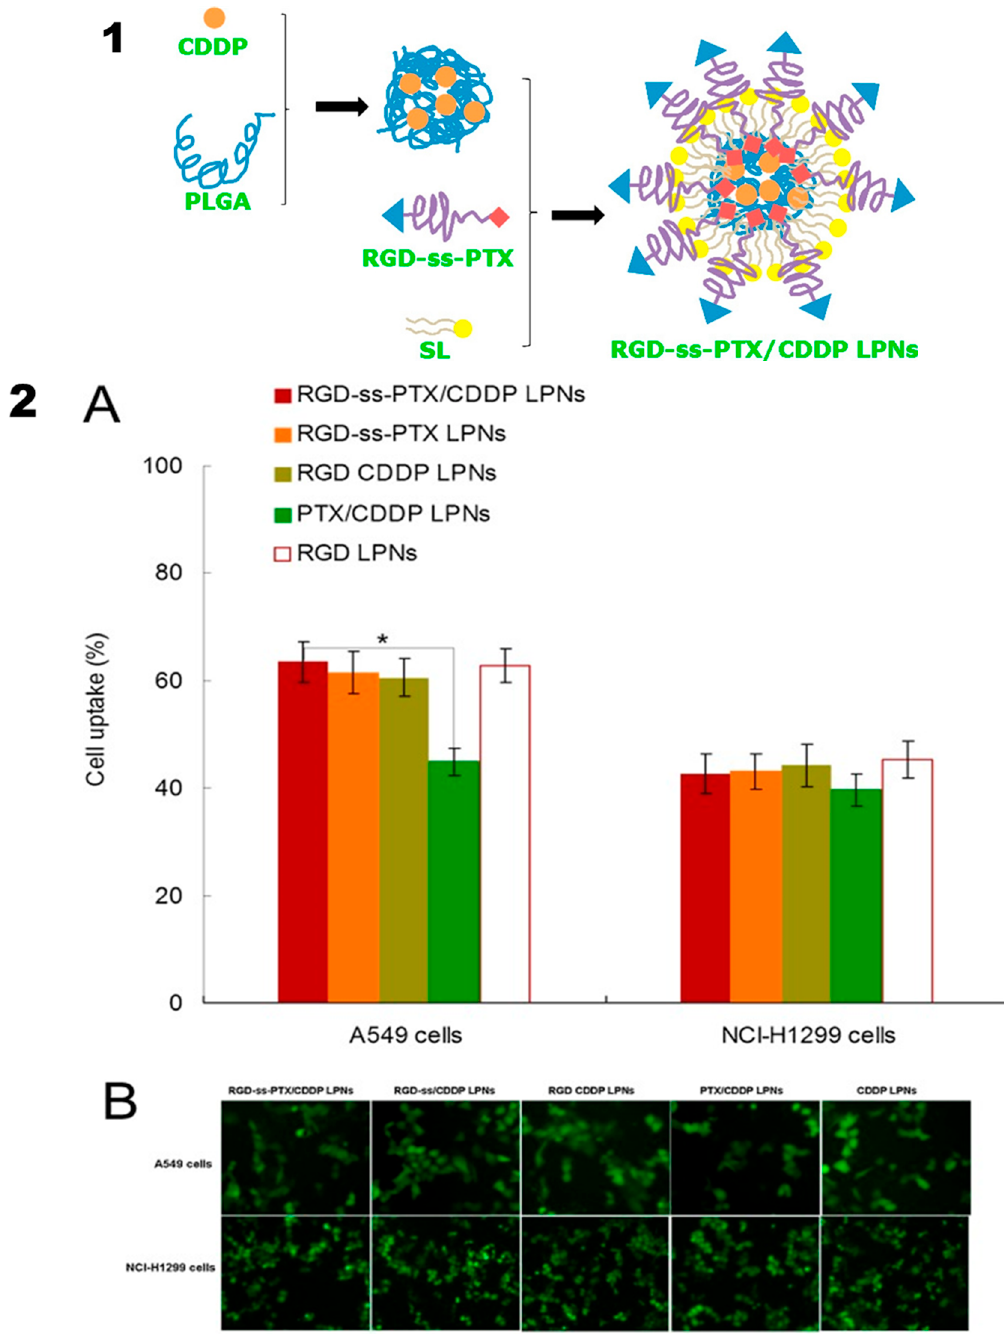
Figure 8. ( 1 ) Synthesis of drug delivery system (DDS) based on redox ‐ responsive polymer ‐ lipid ‐